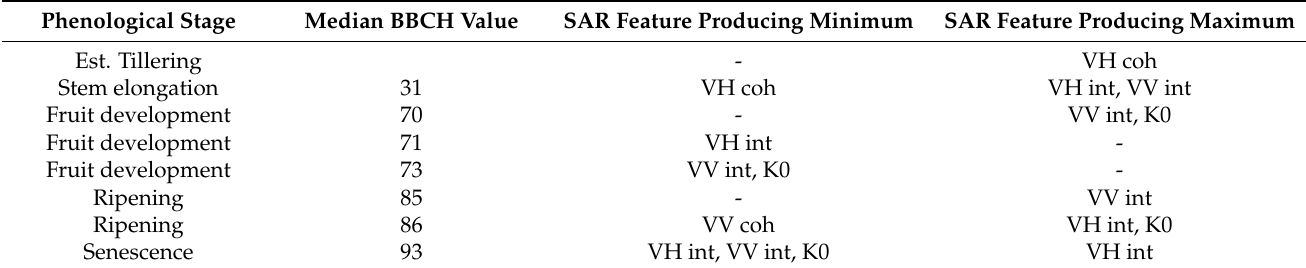
Table 4. Summary of relevant extrema and corresponding BBCH values for wheat signatures. Phenological